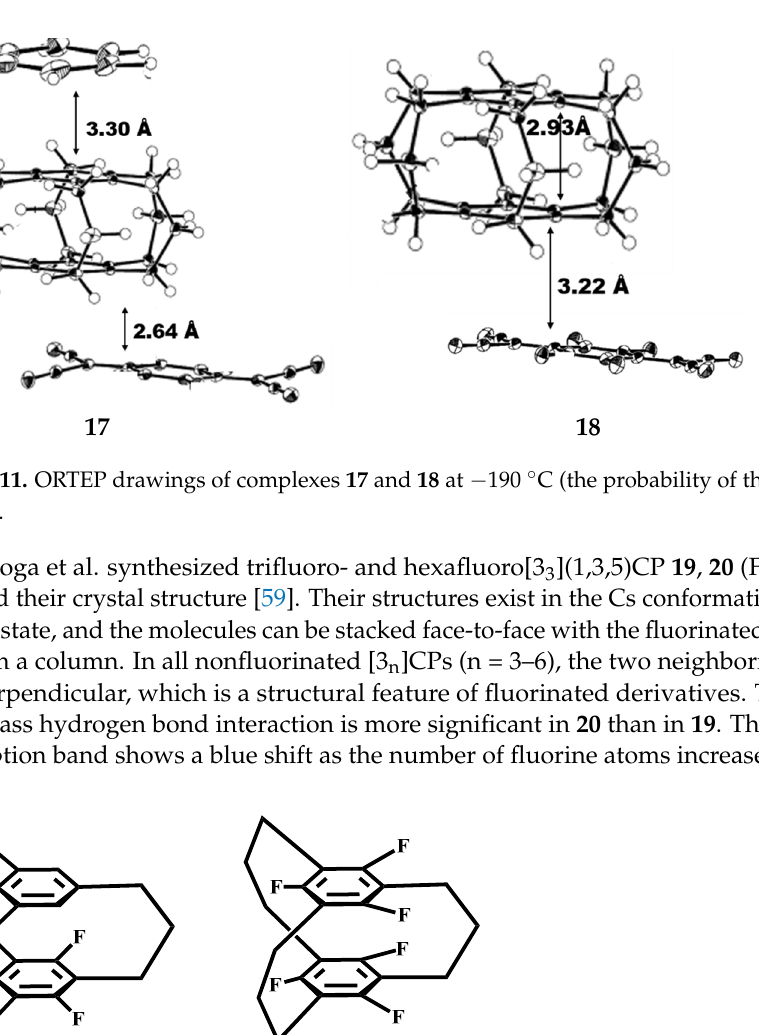
3 ](1,3,5)CP 19 and 20